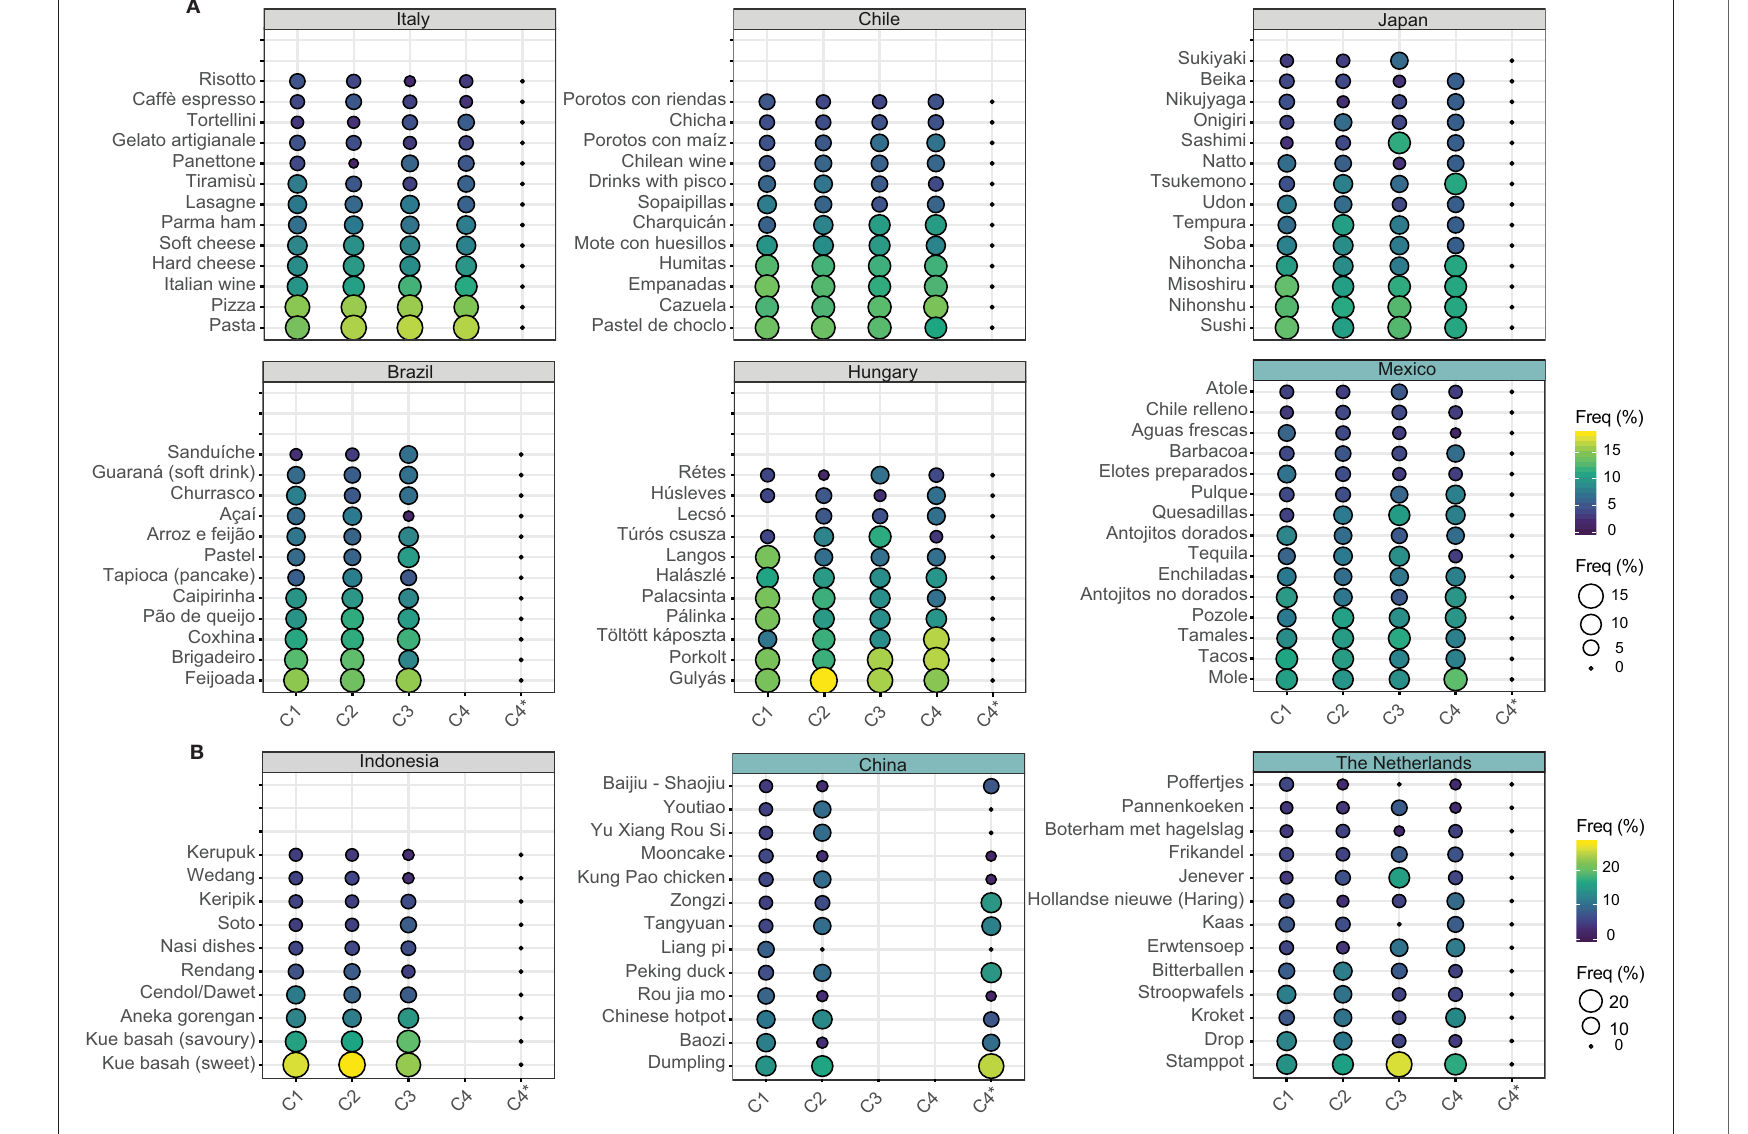
FIGURE 1 | Percentage frequency of traditional foods and beverages (mentioned by ≥ 13% respondents) relative to each age cohort by country. Countries with grey background represent those having a homogeneous food identity and the countries with a blue background those with a heterogeneous food identity. (A,B) Represent different plotting scales. C1 = 18–29 years of age, C2 = 30–39 years of age, C3 = 40–49 years of age, C4 = 50 + years of age; and C4 * = 40 + years of